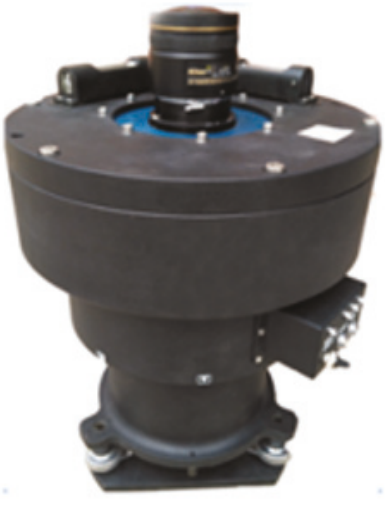
Figure 10: Actual picture of the prototype.